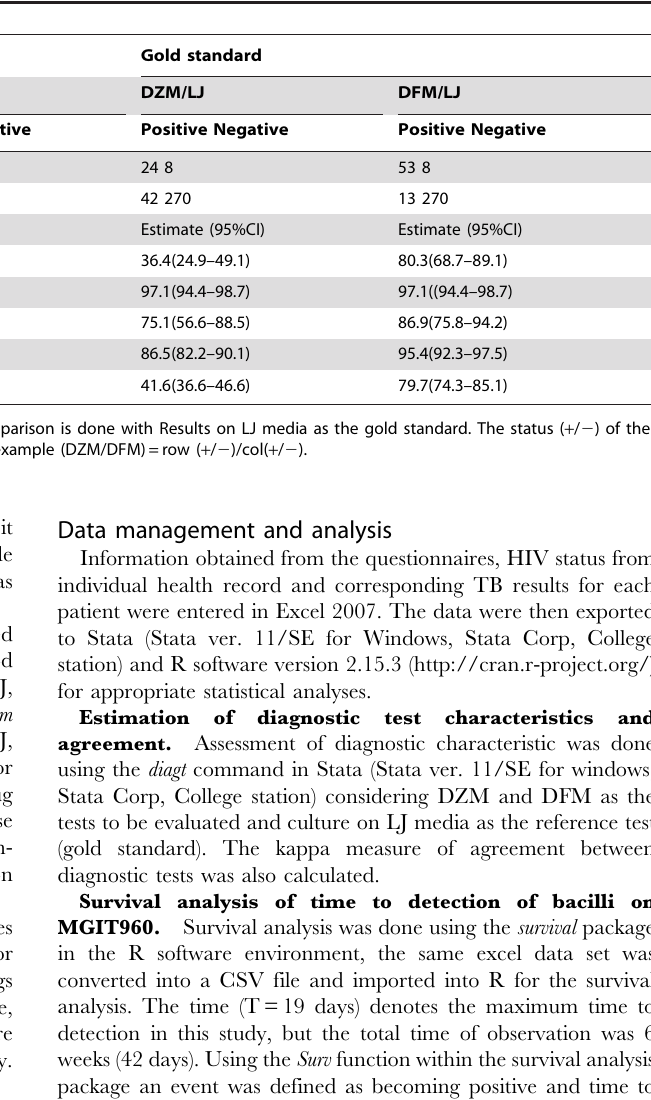
Table 2. Diagnostic performance of DZM&DFM against culture on LJ (gold standard) in detection of bacilli in clinical samples obtained from patients at Mubende referral hospital, Uganda.